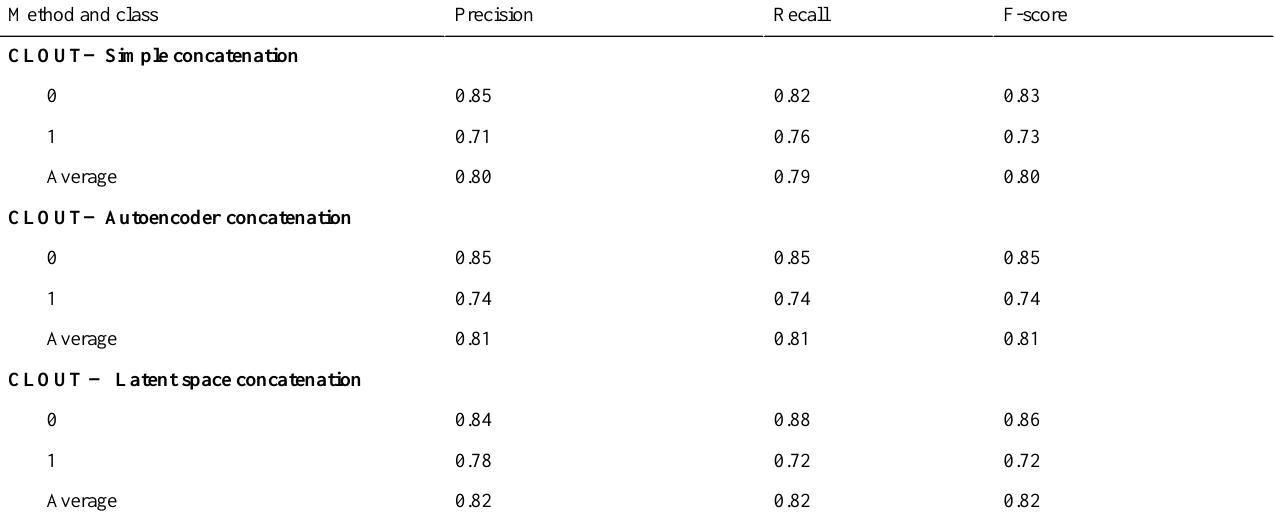
Table 3. Precision, recall, and F-scores for top CLOUT a models.